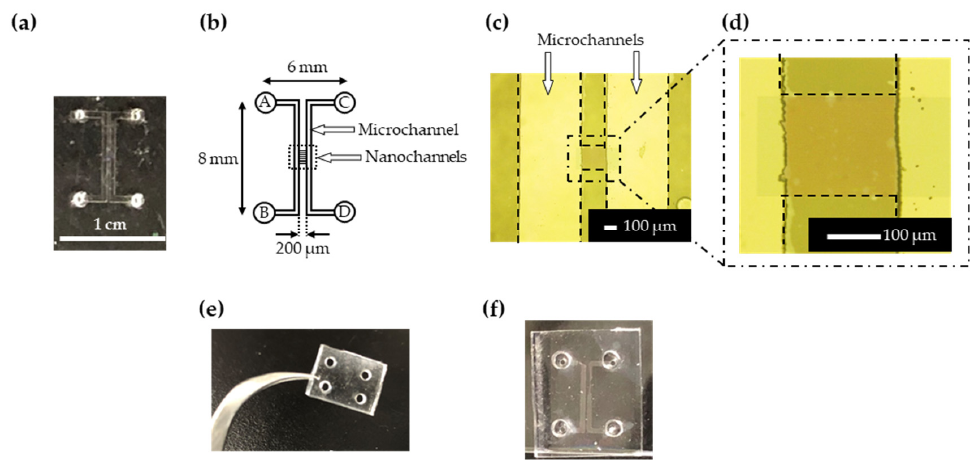
Figure 2. ( a ) Photograph and ( b ) channel configuration of the micro-nanofluidic device. ( c ) Microscopic images of the microchannels near the nanochannels. Black dashed lines represent the microchannels and nanochannels. ( d ) Enlarged image of the nanochannels. Photographs of ( e ) the PDMS reservoirs and ( f ) the device bonded with reservoirs.